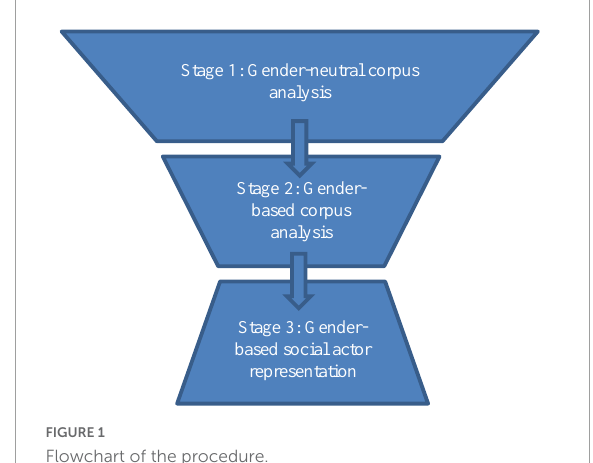
FIGURE1 Flowchart of the